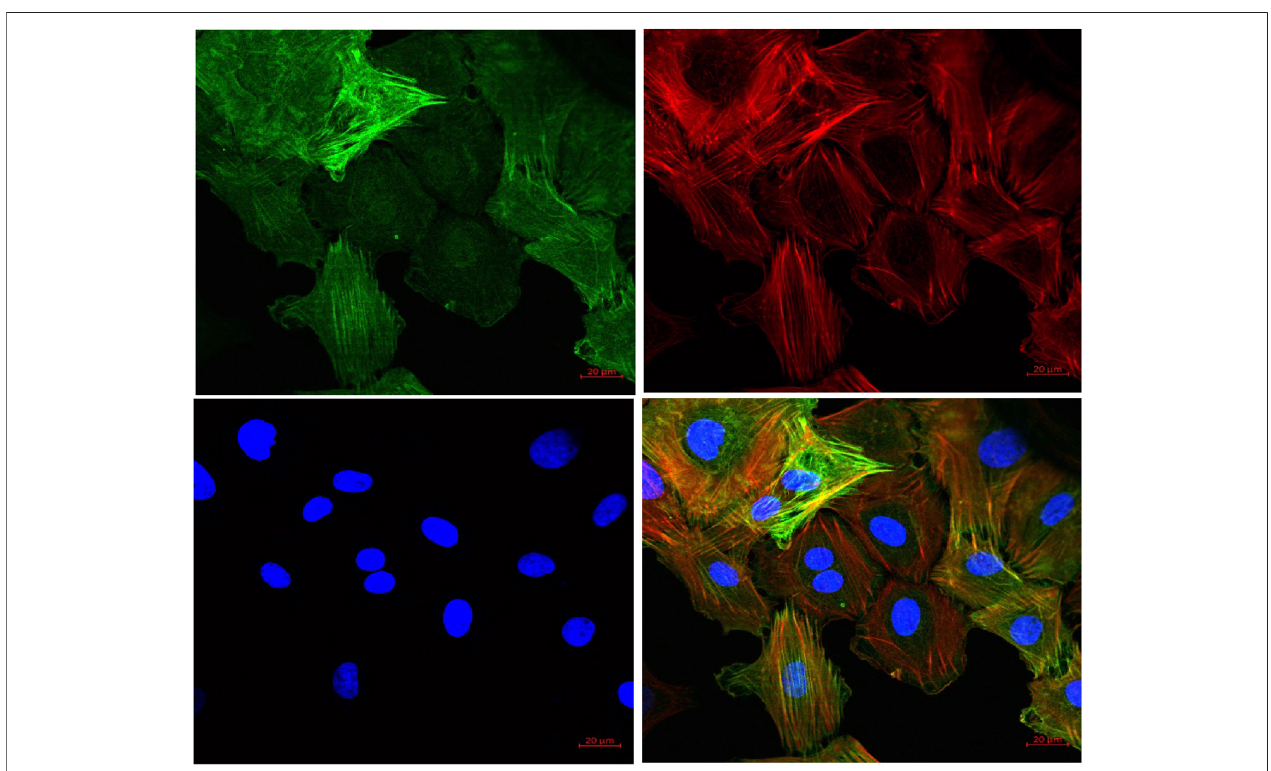
FIGURE 6 | Representative pictures of cells derived from rat aorta stained with markers for VSMCs. Mesenchymal marker alpha-smooth muscle actin ( α -SMA) (green) and F-actin (red) were stained positive in VSMCs. The nucleus of VSMC was stained by DAPI (blue) (40X).